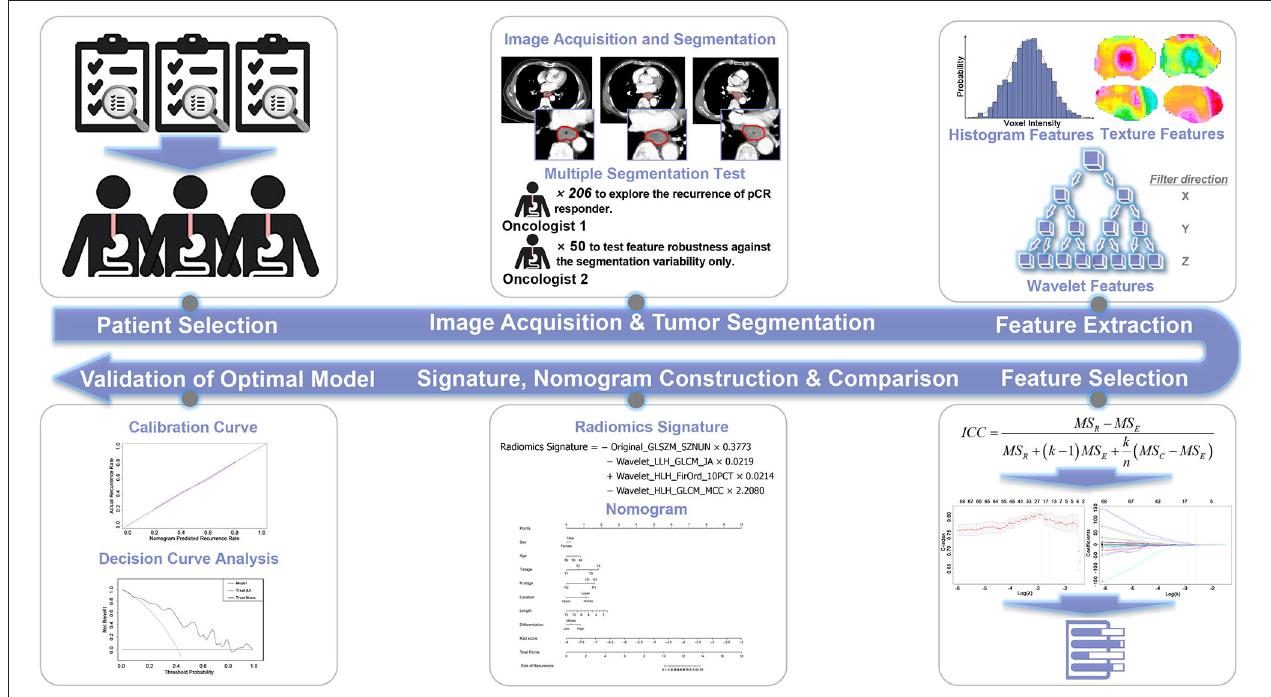
FIGURE 1 | Workflow of this